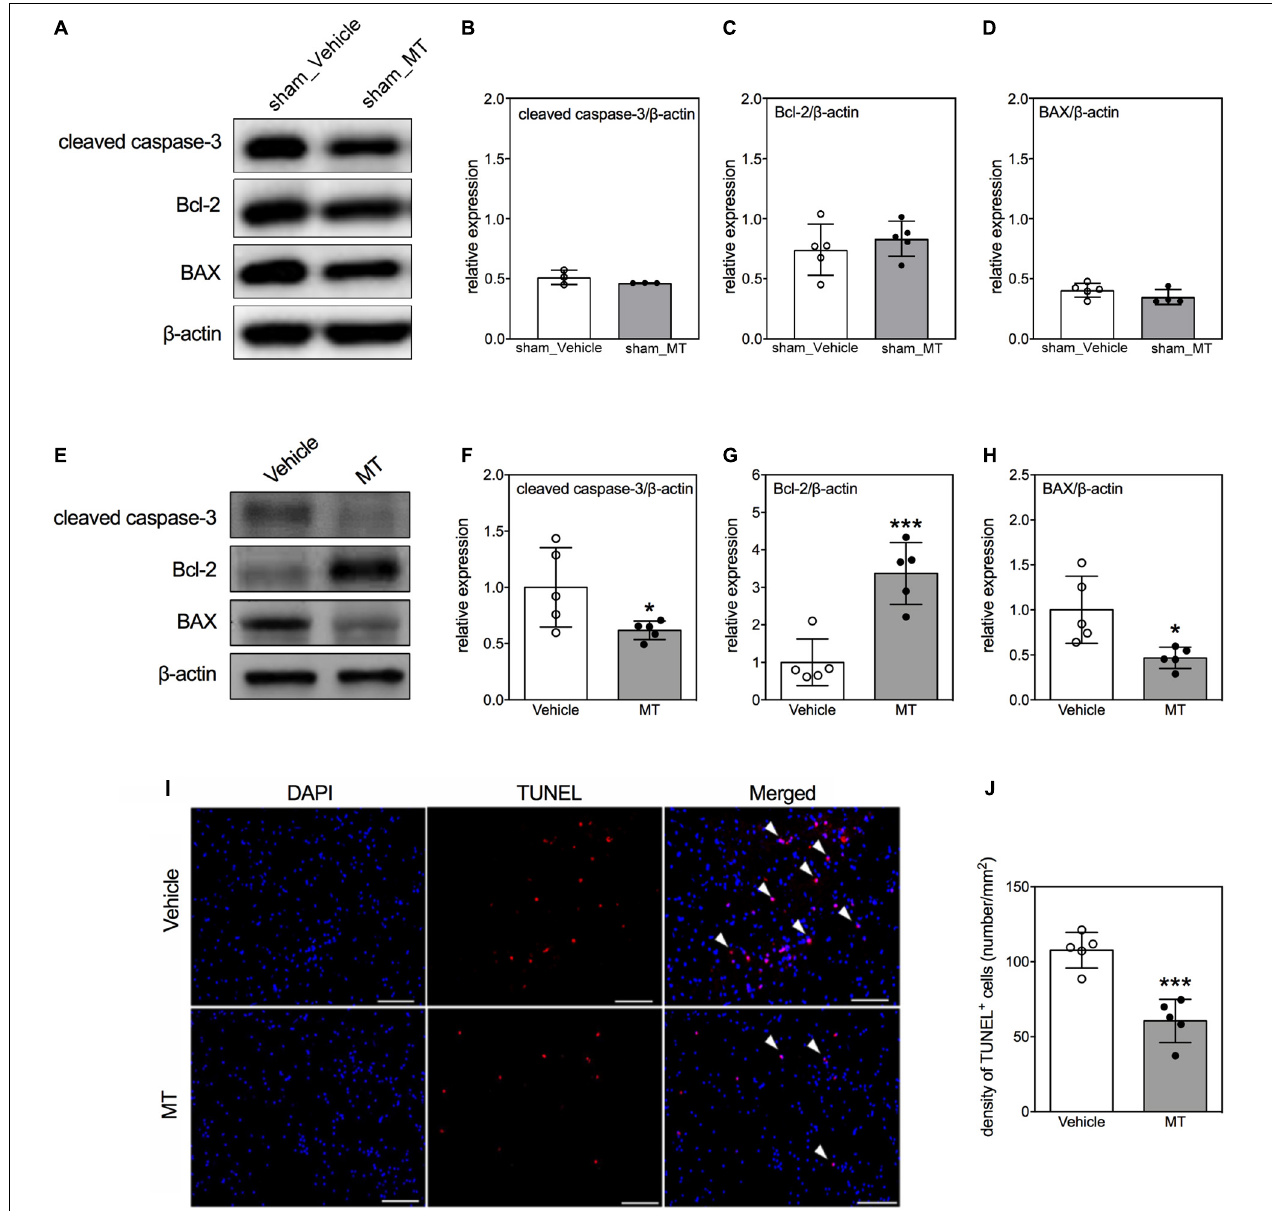
FIGURE 4 | Effects of mitochondrial transplantation on cellular apoptosis in the injured spinal cord of rats with traumatic SCI. (A) Representative micrograph of Western blots of cleaved caspase-3, Bcl-2, and BAX in sham control groups. (B–D) Corresponding quantitative results of relative expression of cleaved caspase-3, Bcl-2, and BAX in sham control groups. (E) Representative micrograph of Western blots of cleaved caspase-3, Bcl-2, and BAX in SCI groups on PID 1. (F–H) Corresponding quantitative results of relative expression of cleaved caspase-3, Bcl-2, and BAX in SCI groups on PID 1. The 1-cm spinal cord specimens centered at the epicenter of the injured site were used in Western blots. (I) Representative micrographs of TUNEL assay. The white arrowheads indicate both DAPI and TUNEL dual-positive cells. The sections used in TUNEL assay were obtained from the 1-cm spinal cord specimens centered at the epicenter of the injured site. Scale = 100 µ m. (J) Quantitative results of the TUNEL assay. Data were expressed as mean ± standard deviation. * p < 0.05, *** p < 0.001 two-tailed Student’s t -test. N = 3–5. MT, mitochondria